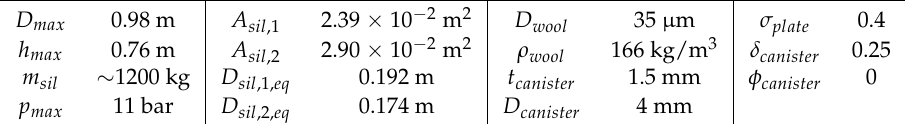
Table 1. Silencer main dimensions and physical quantities used in the acoustic simulations. D sil , max and h sil , max are the main diameter and height, respectively; m sil is the weight; p max is the max operative pressure; A sil ,1 and D sil ,1, eq are the clean passage area and the equivalent diameter for the primary circuit; A sil ,2 and D sil ,2, eq are the clean passage area and the equivalent diameter for the secondary circuit. For Grade #000 fine steel wool, D wool is the mean fiber diameter, and ρ wool is the material apparent density. For the metal canisters, σ canister is the area porosity (the hole’s fraction of the boundary surface area); t canister is the plate thickness; d canister is the hole diameter; δ canister is the end correction to the reactance; and φ canister = 0 is the flow